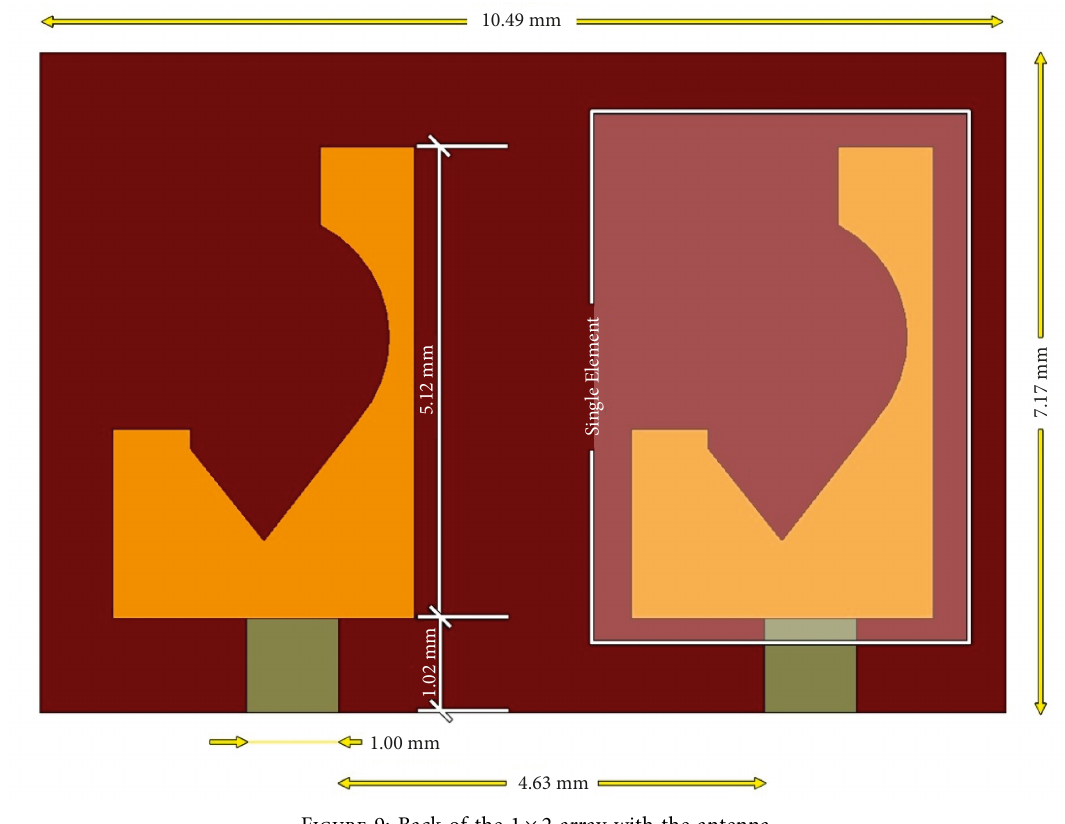
Figure 9: Back of the 1 × 2 array with the antenna.